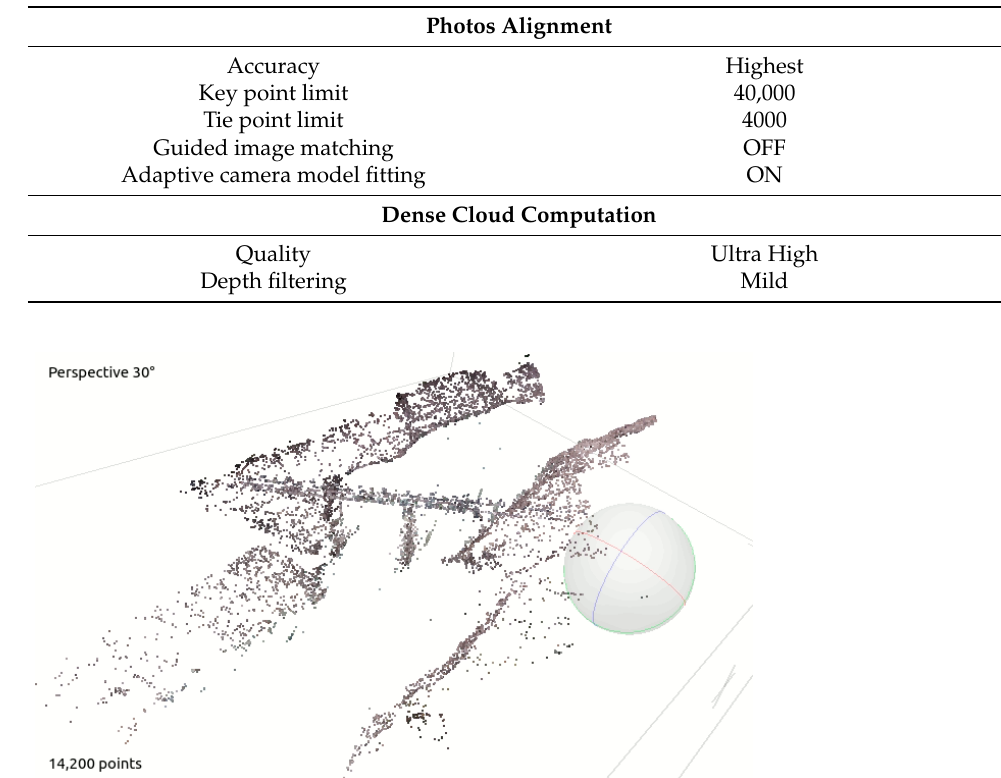
Figure 3. Example of images recorded by the UAV with FOV = 77° and gimbal pitch angle = 45°. Table 1. Parameters used for point cloud computation. References can be found in the documentation of the software Metashape [32].